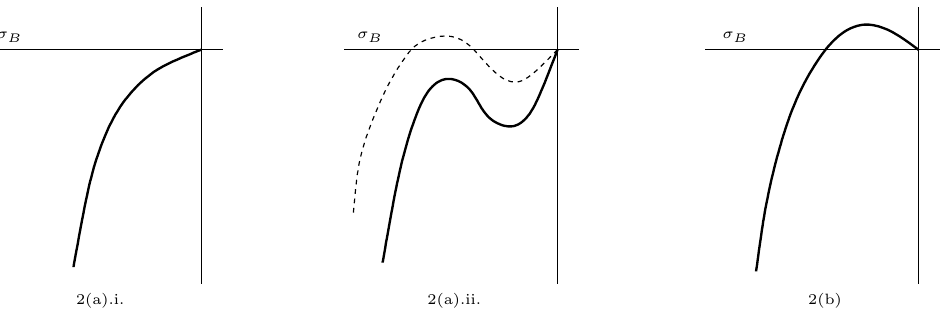
Figure 4 . E(cid:11)ective potential in the unHiggsed phase for A u